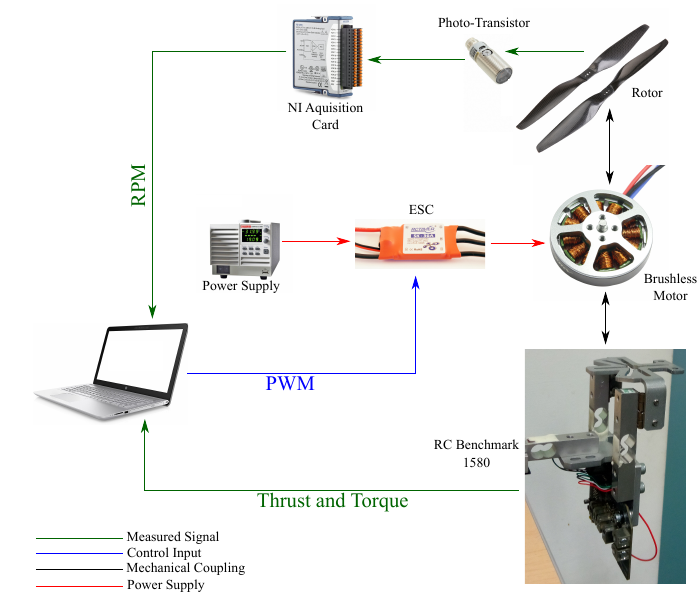
Figure 9. Experimental setup. Table 2. Instrumentation characteristics.